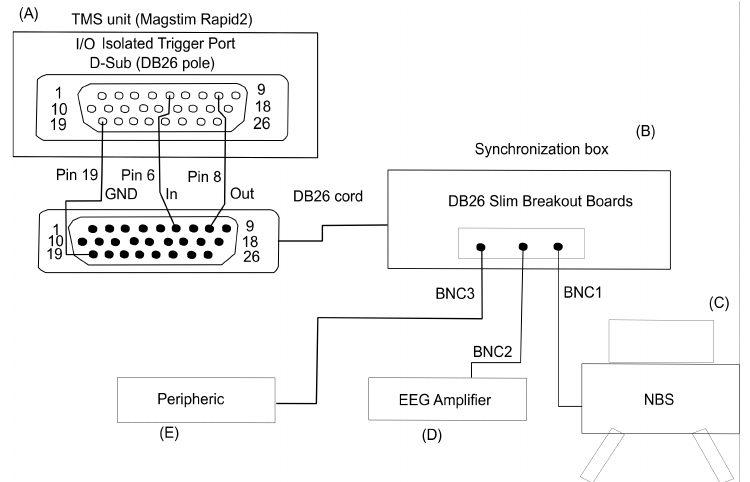
Figure 1. Proposed design for a customized synchronized layout for the Magstim Rapid2 TMS unit. ( A ) Magstim Rapid2 TMS unit; ( B ) our proposed Synchronization box; ( C ) the Neuro Brain Navigation System (NBS); ( D ) EEG Amplifier and ( E ) any other peripheral device (e.g., customized software suites for real-time TMS-evoked EEG potential (TEP) visualization). The Magstim